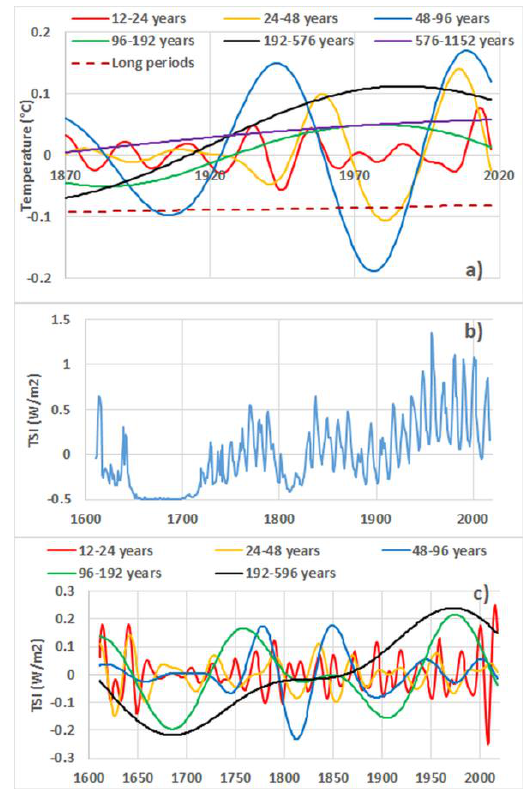
Figure 4. ( a ) Components of the weighted sum of the SST anomalies into the bands characteristic of subharmonic modes (surface temperature in the northern hemisphere); ( b ) the Total Solar Irradiance (TSI); ( c ) the components of the TSI within the bands characteristic of subharmonic modes (signals are centered). TSI reconstruction is based on NRLTSI2 [26].